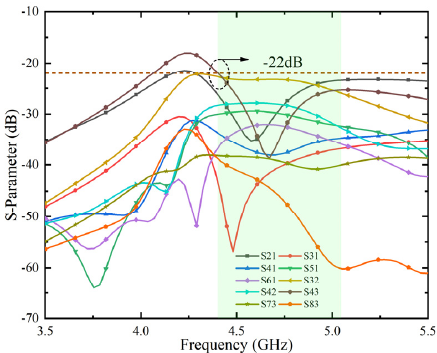
Figure 10. Transmission coefficients of MIMO antenna systems with decoupling.